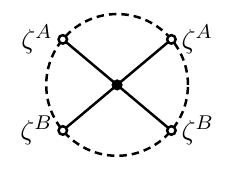
Figure 11 . Contact diagram contributing at order 1